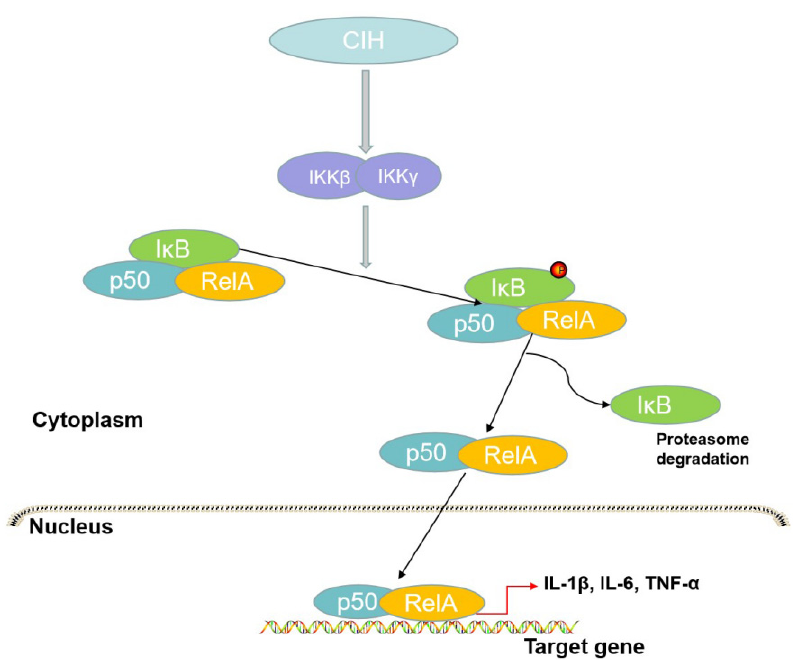
Figure 2. The canonical pathway of NF- κ B. In this process, IKK β activated by CIH leads to the phosphorylation of I κ B to form the RelA/p50 complex. The complex translocates to the nucleus to promote the transcription of target genes and I κ B is subsequently degraded by the proteasome.